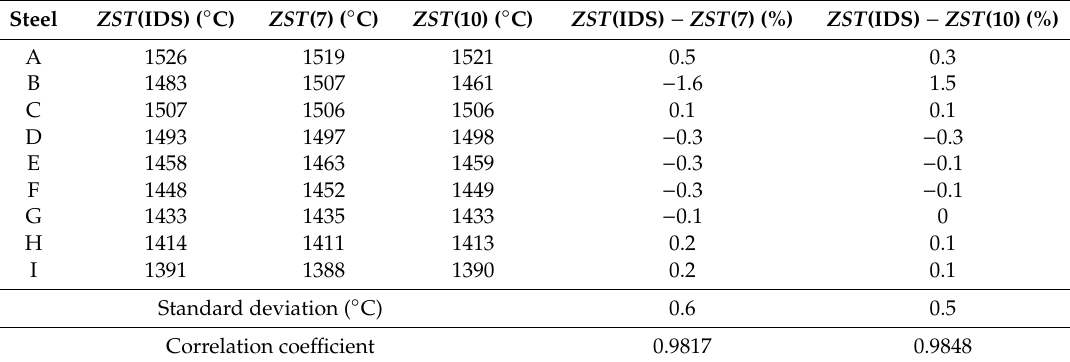
Table 6. Evaluation of accuracy of Equations (7) and (10) intended for the calculation of the zero strength temperatures of the investigated steels.